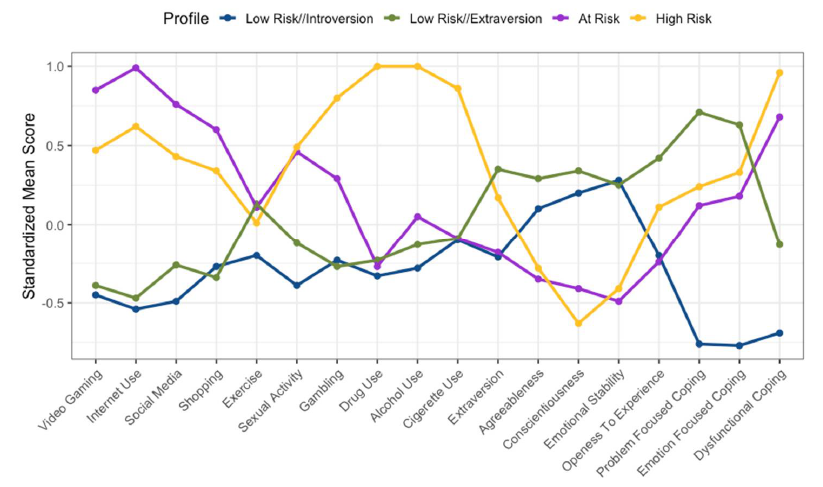
Figure 3. Standardized mean score graph of the AU cohort.